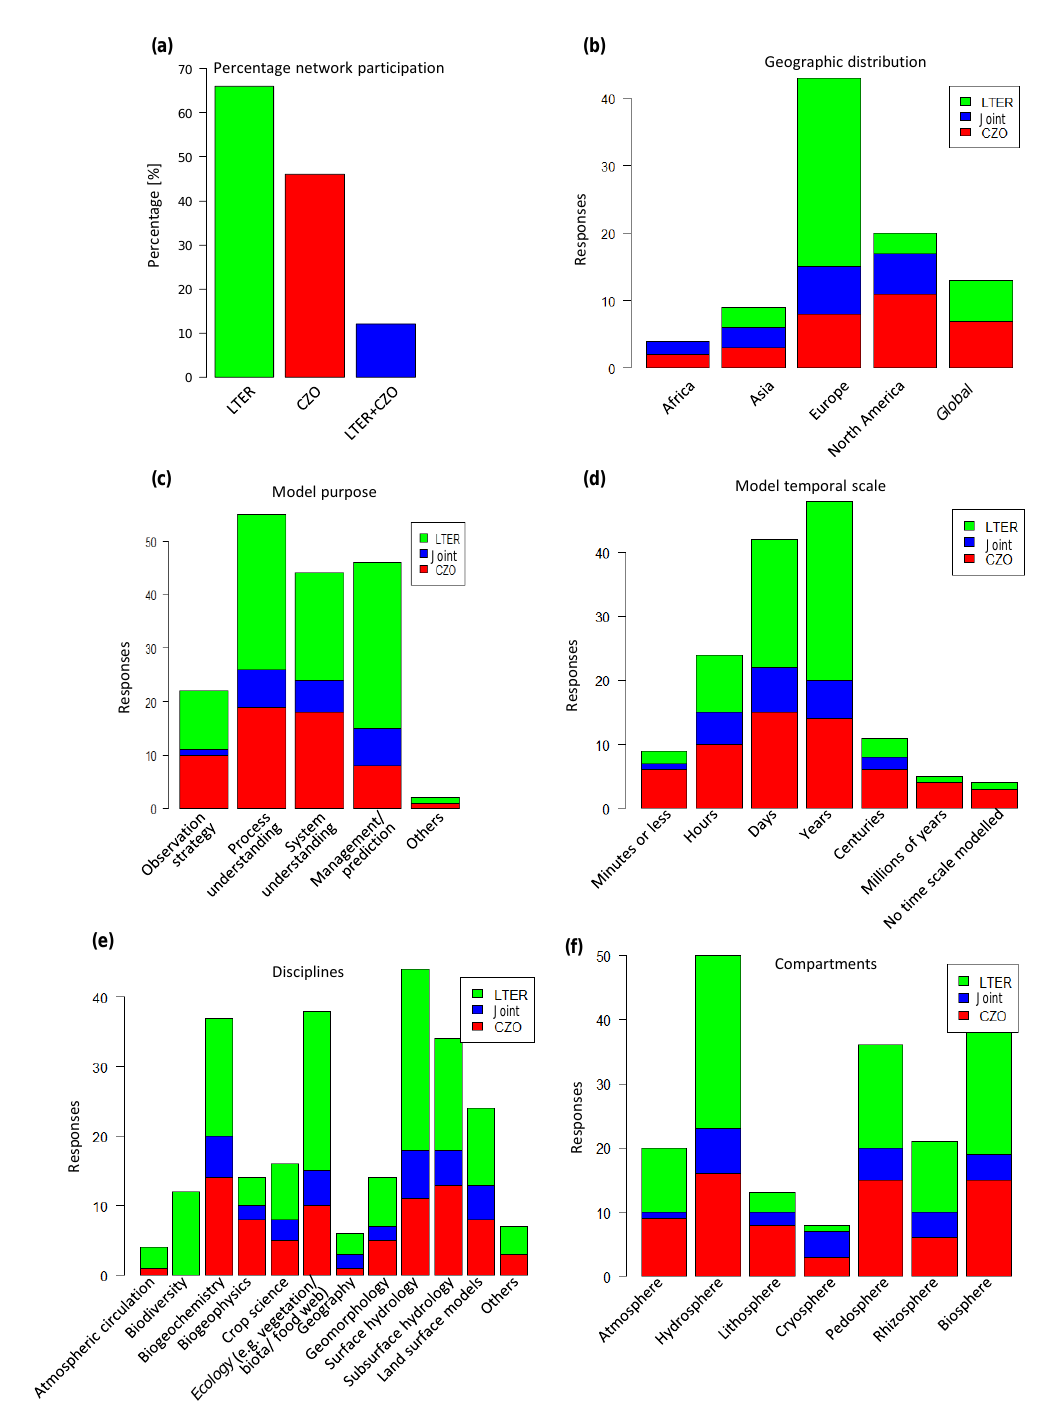
Figure A1. Distribution of respondents associated with LTER, CZO, or both sites (a) to geographic region mod- elled (b) , purpose of the modelling (c) , timescale modelled (d) , disciplines (e) , and compartments (f) integrated.